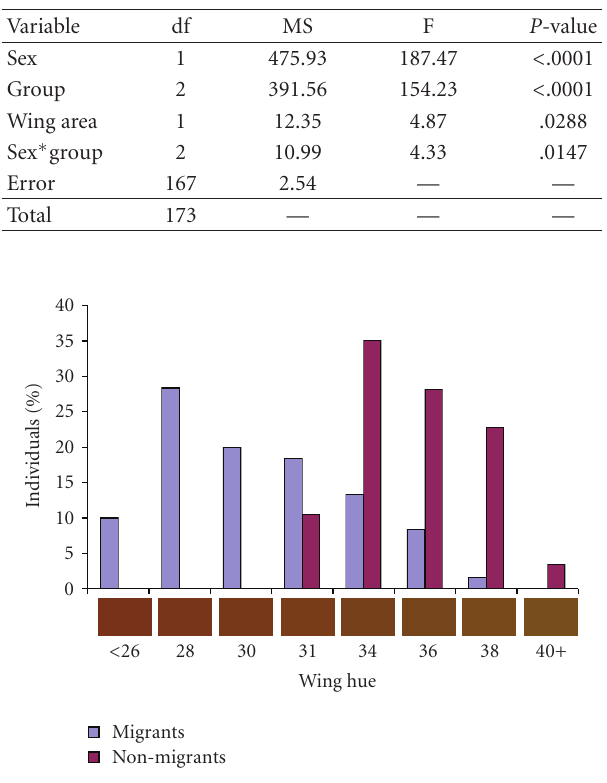
Figure 2: Frequency distribution of wing color (hue score, measured in degrees) observed among all migrating ( n = 60) and nonmigrating ( n = 114) monarchs. Colored scale included which shows the hue scores of each category.